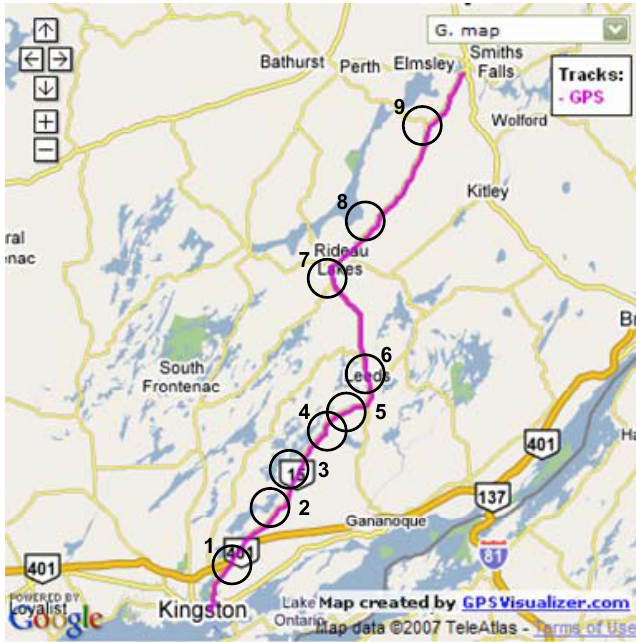
Figure 12. The second road test trajectory (for MEMS based IMU) with the location of some intentionally introduced GPS outages.